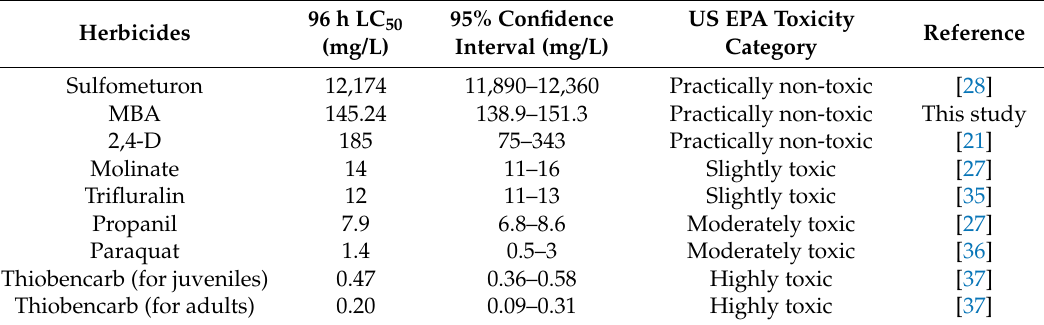
Table 2. Estimated 96 h LC 50 values, 95% confidence limits and toxicity categories of MBA and some other herbicides to P.